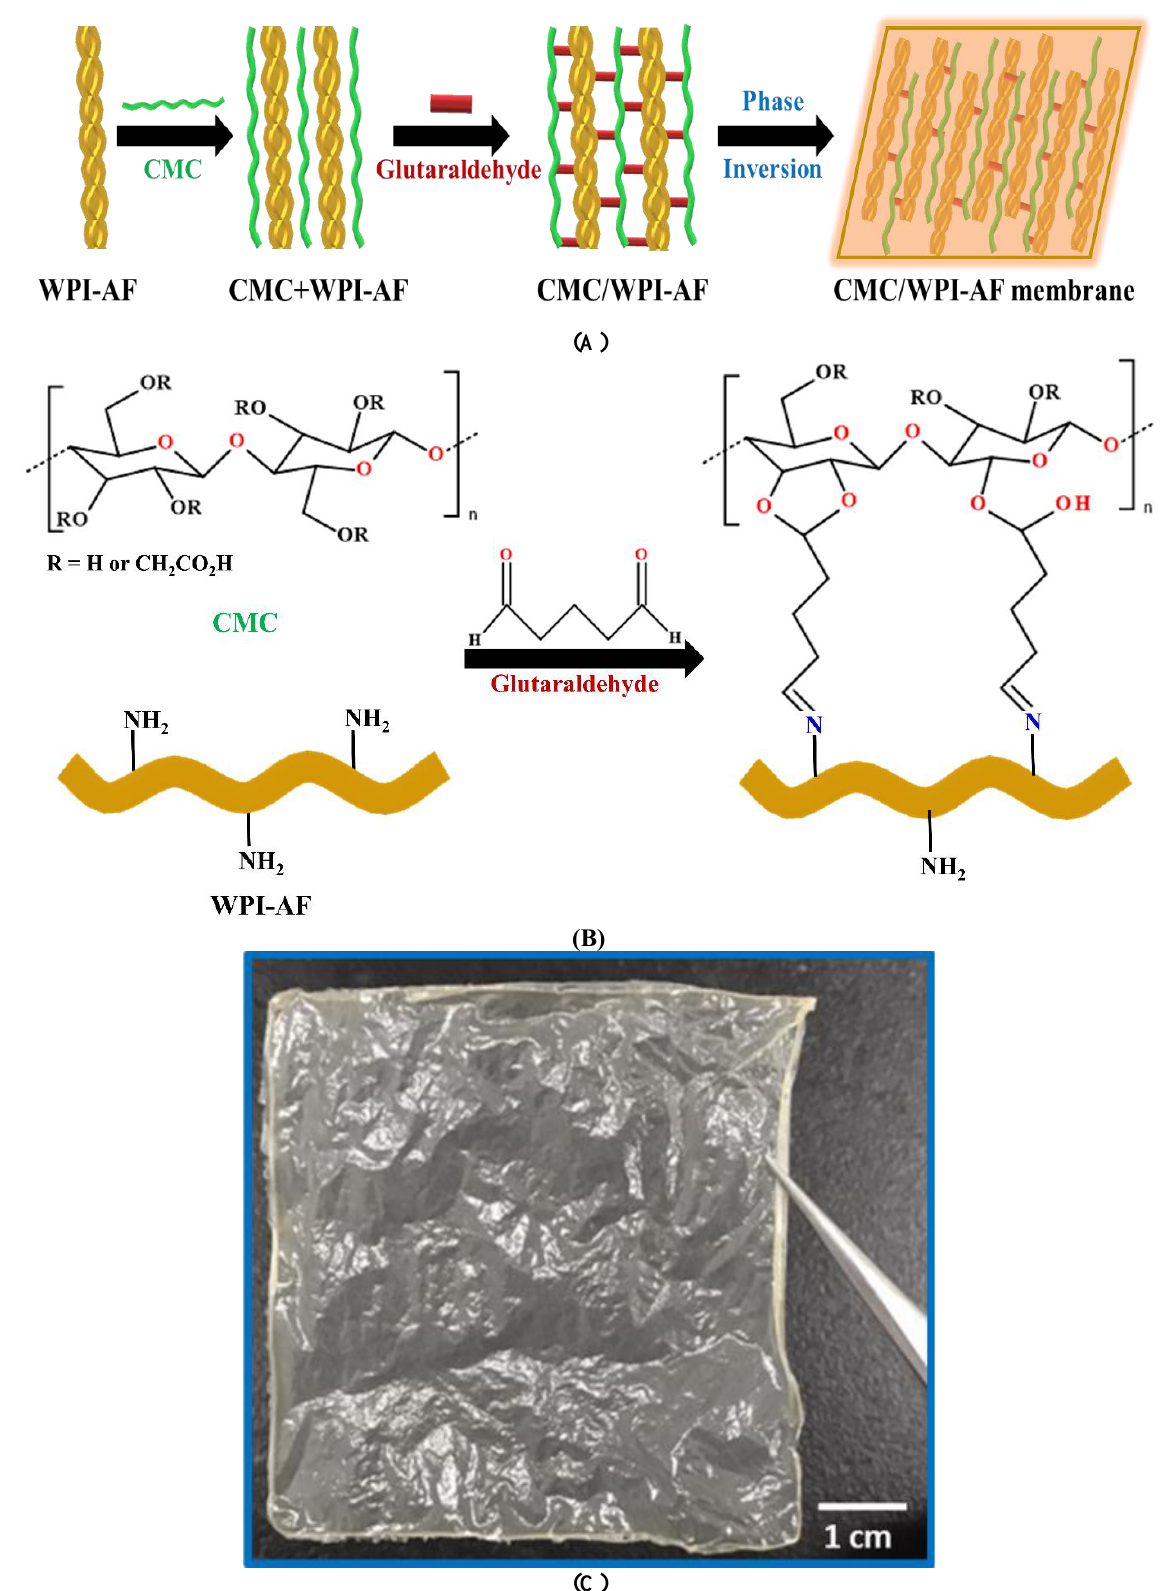
Figure 3. ( A ) Schematic diagram of the synthesis strategy for CMC/WPI - AF membranes. ( B ) Cross - linking of WPI - AF and CMC using glutaraldehyde. ( C ) Physical appearance of CMC/WPI - AF membrane with a CMC:WPI - AF mass ratio of 1:1. (Scale bar = 1 cm).